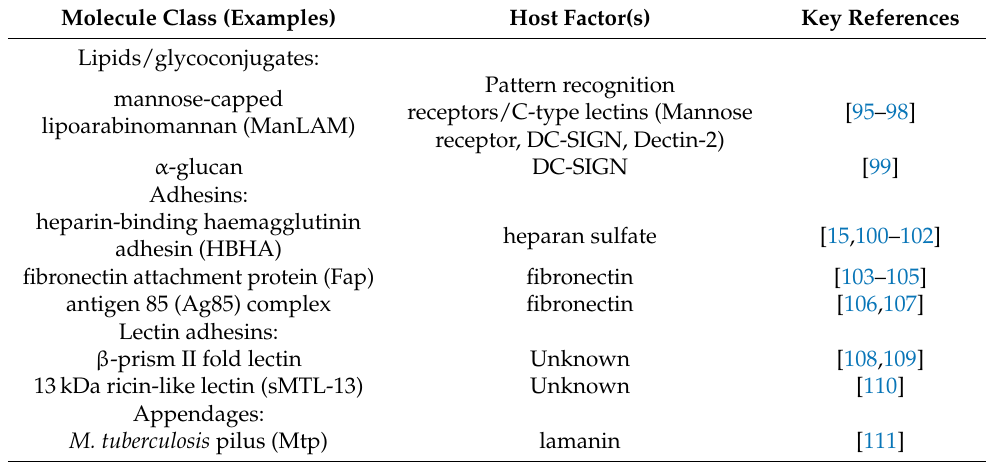
Table 1. Major known mycobacterial adhesive molecules and their host factor